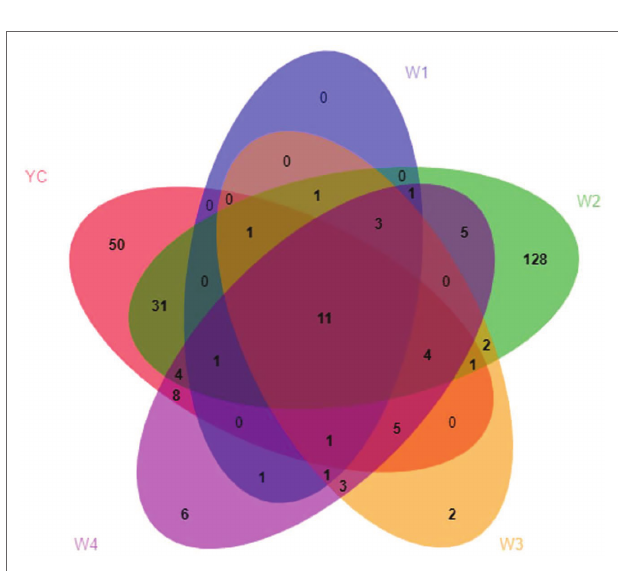
FIGURE 2 | Venn analysis of the OTUs. Different groups are shown in different colors, and the numbers in the overlapping portions represent the number of species common to all the